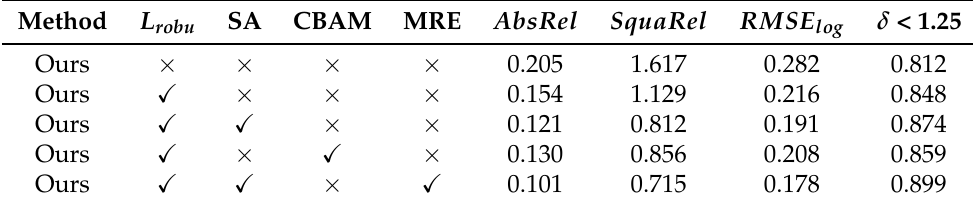
Table 5. Ablation study on different variants of our network using the KITTI dataset. L robu , SA, CBAM, and MRE represent robust loss function, self-attention module, channel and spatial attention module, and multi-scale resolution